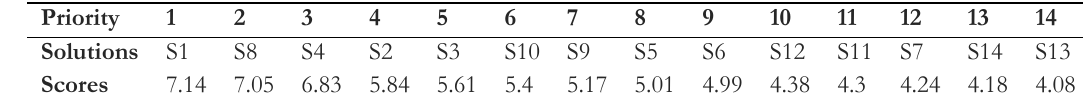
Table 7. The final priority for the proposed